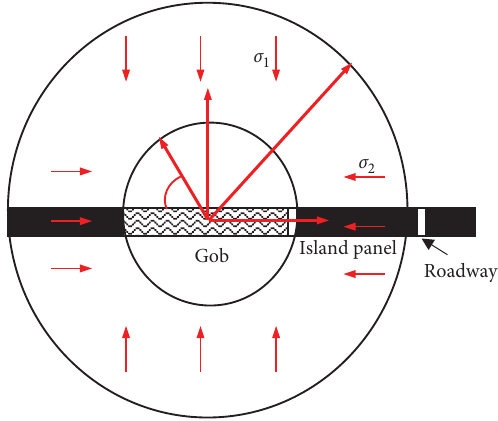
Figure 7: Stress distribution after LW 1300 was